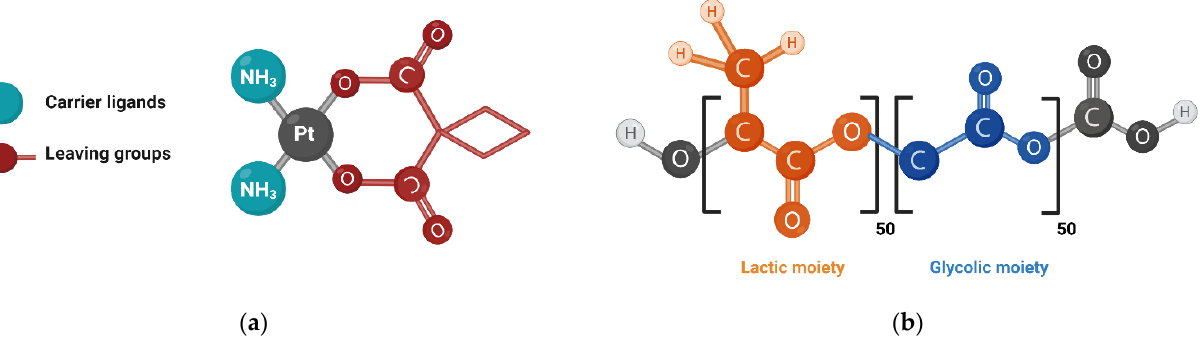
Figure 1. ( a ) Carboplatin structure; ( b ) Structure of PLGA 50/50 with carboxylic terminal group.